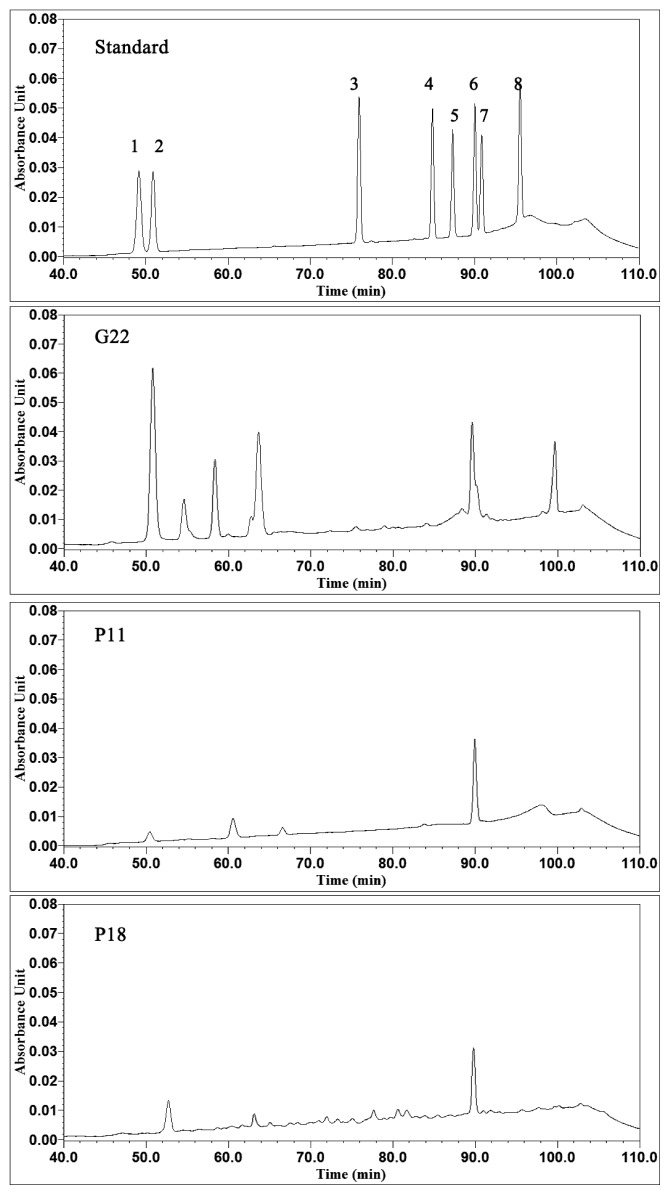
High-performance liquid chromatography (HPLC) spectra of the ginsenoside standards and the culture filtrates of the representative strains. 1, Rg1; 2, Re; 3, Rf; 4, Rb1; 5, Rc; 6, Rb2; 7, Rb3; 8, Rd.